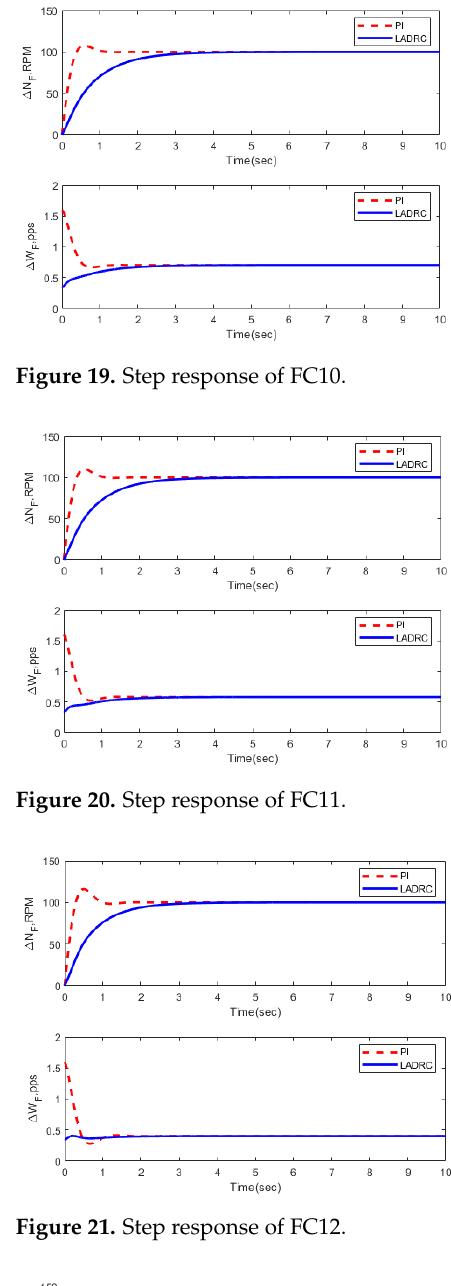
Figure 18. Step response of FC09.